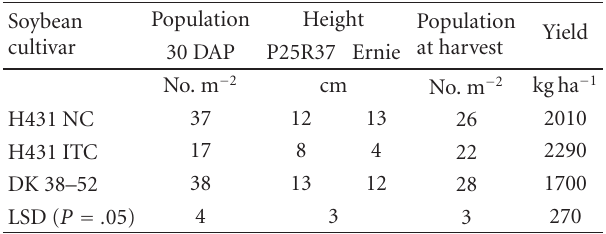
Table 7: Soybean plant population and height 30 d after planting (DAP), plant population at harvest, and yield main e ff ects for soybean cultivars in a relay-intercropping system, planted in 38-cm wide-row wheat in 2003, 2004, and 2005. All data except height were averaged over relay-intercropped wheat cultivars (Pioneer 25R37 and